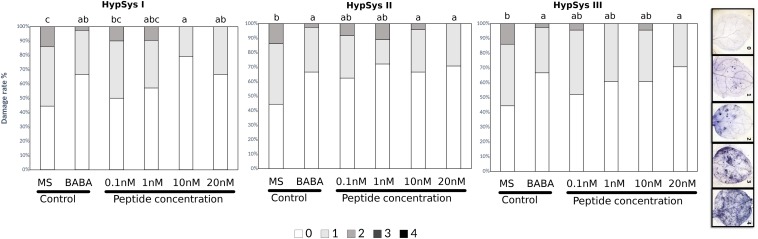
HypSys peptides induced-resistance assays against Plectosphaerella cucumerina in Arabidopsis plants. Infection levels 5 days after inoculation quantified by a disease rating in trypan blue stained leaves, measured as a percentage of the infected leaf surface. Arabidopsis Col-0 plants were treated with increasing concentrations of HypSysI, HypSysII, and HypSysII (0.1, 1, 10, and 20 nM) 24 h before infection with 1 μl droplets of 5 × 10E3 spores/ml of P. cucumerina BMM. ß-amino butyric acid (BABA) at 1 ppm was used as a positive control. Colors mean % of diseased leaves in a scale (0 = healthy leaves; 1 = leaves with less than 25% of diseased surface; 2 = leaves with 25–50%; 3 = leaves with 50–75% of the diseased surface, 4 = leaves with more than 75% of the surface diseased). Different letters indicate statistically significant differences (ANOVA, Fisher’s Least Significant Difference (LSD) test; P < 0.05, n = 24). The experiment had 6 plants per treatment and was repeated at least three times with similar results.